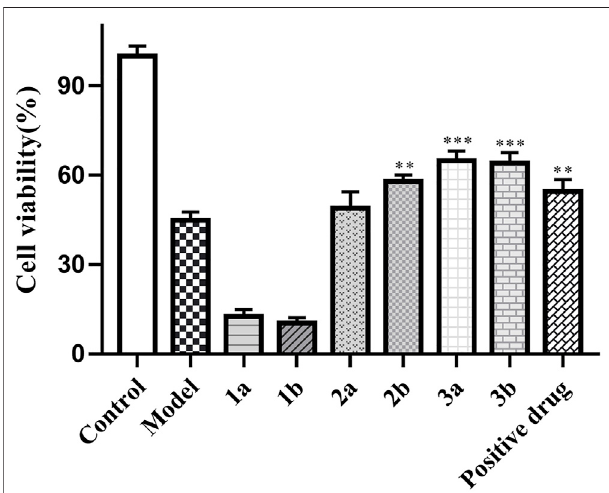
FIGURE 8 | Neuroprotective activities of compounds 1 – 3. PC12 cells were in the presence of isolated compounds at a concentration of 10 μ M with theH 2 0 2 -induced injurymodel. Theircellviabilitiesweremeasured bytheMTT assay ( n = 3). Data are expressed as mean ± S D. *** p < 0.001 vs. the model